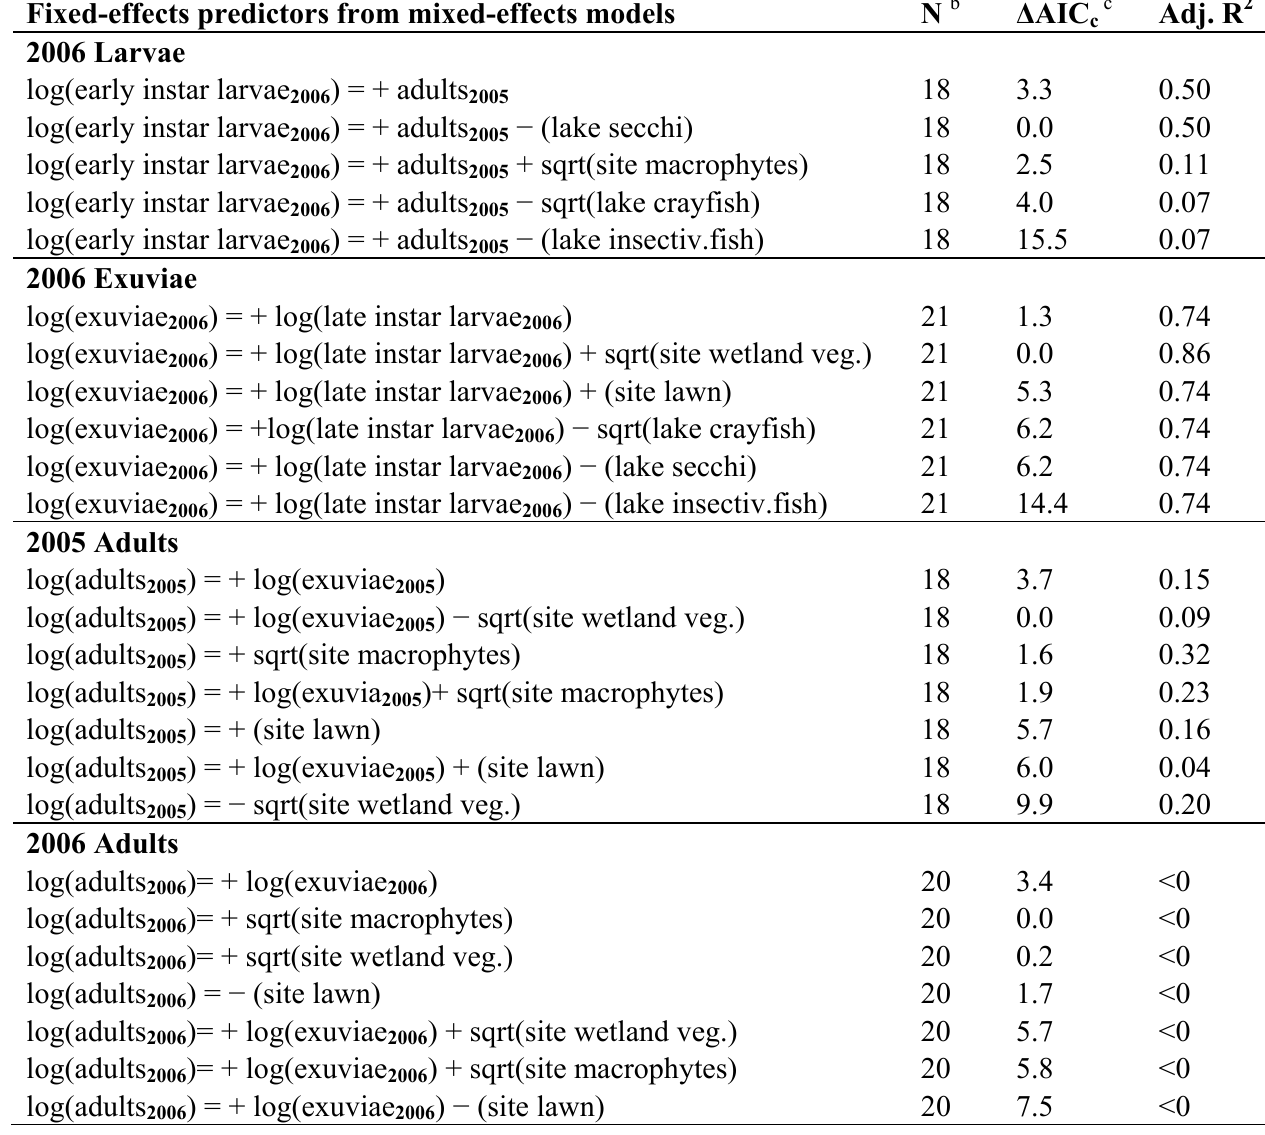
Table 2. Mixed-effects linear regression models a using population and habitat variables to predict Gomphidae densities at lakeshore sites in northern Wisconsin. Signs in front of independent variables indicate the sign of the coefficient in the